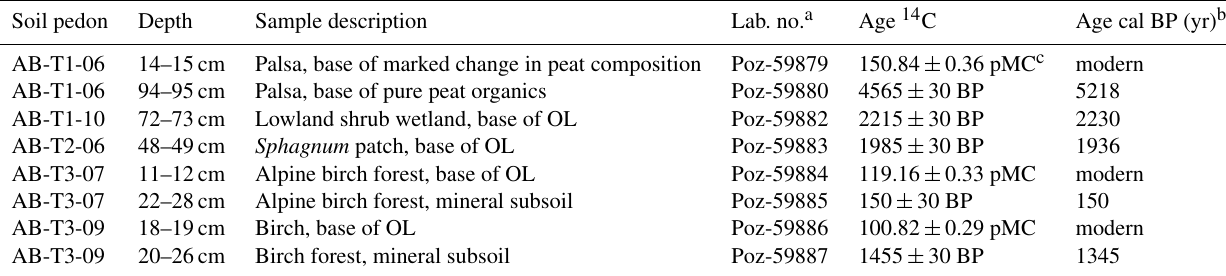
Figure 8. Summary of the predicted soil organic carbon (SOC) at different spatial resolutions. The dots show the development of the SOC– Tot, while the colored dots show the SOC stored in individual classes extracted using the LCC at 1m spatial resolution. The R 2 values are estimated using the full pedon dataset including pseudo-sampling points. Table 2. Summary of radiocarbon